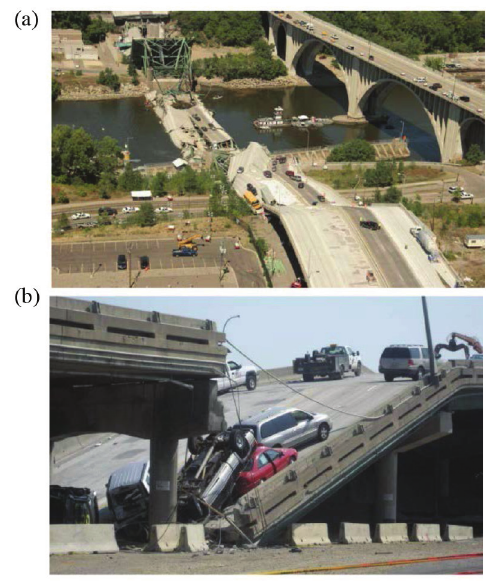
Fig. 1. Collapse of the I-35W Mississippi River Bridge, USA (courtesy of Federal Highway Administration and Context Sensitive Solutions and Creative Commons 1